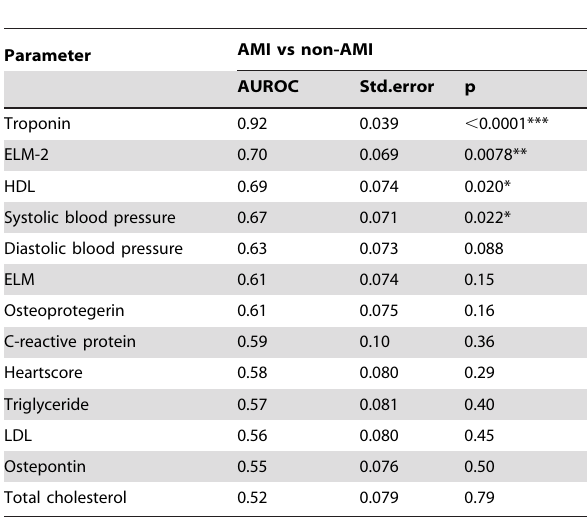
Table 4. Diagnostic power of each biomarker for the separation of patients with AMI compared